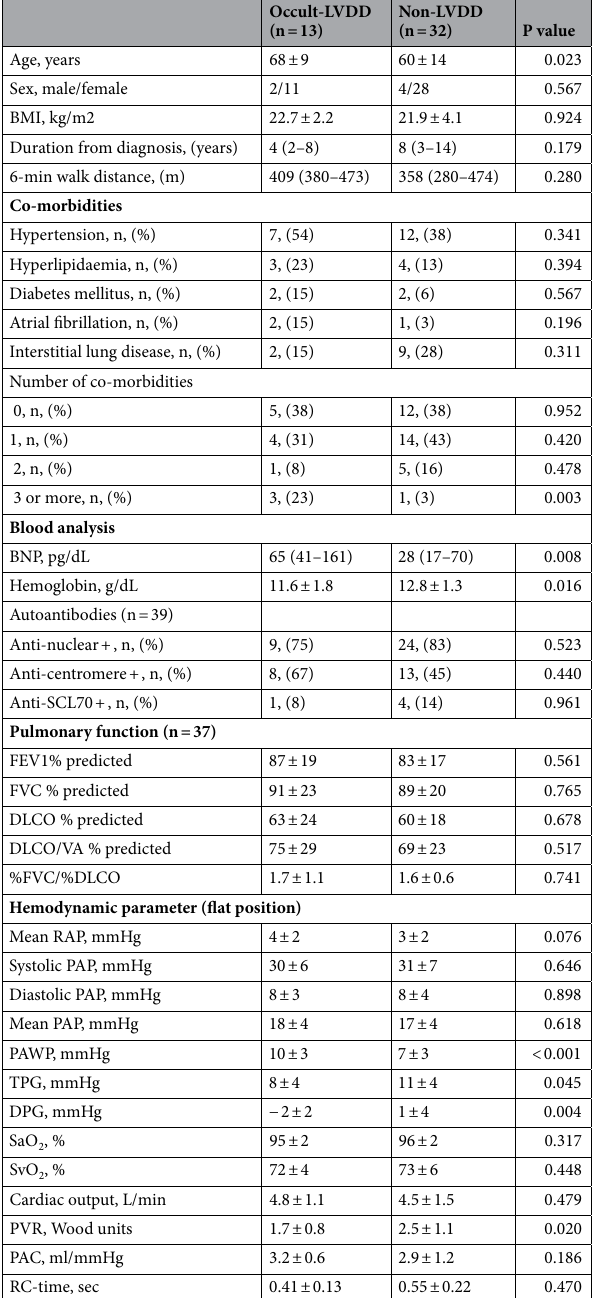
Table 1. Baseline characteristics of the study patients. Values are reported as means ± standard deviation (SD), or medians (25th, 75th interquartile ranges), where appropriate. BW, body weight; DPG, diastolic pulmonary pressure gradient; LVDD, left ventricular diastolic dysfunction; PAC, pulmonary artery compliance, PAP, pulmonary artery pressure; PAWP, pulmonary artery wedge pressure; PVR, pulmonary vascular resistance; RAP, right atrium pressure; RC time, the time constant of the pulmonary circulation, SaO 2 , O 2 saturation in arterial blood; SvO 2 , O 2 saturation in the pulmonary artery; TPG, transpulmonary pressure gradient; %FEV1: forced expiratory volume in 1 s %predicted, %FVC: forced vital capacity %predicted, %DLCO: diffusing capacity of the lung for carbon monoxide %predicted; DLCO/VA % predicted: diffusing capacity divided by the alveolar